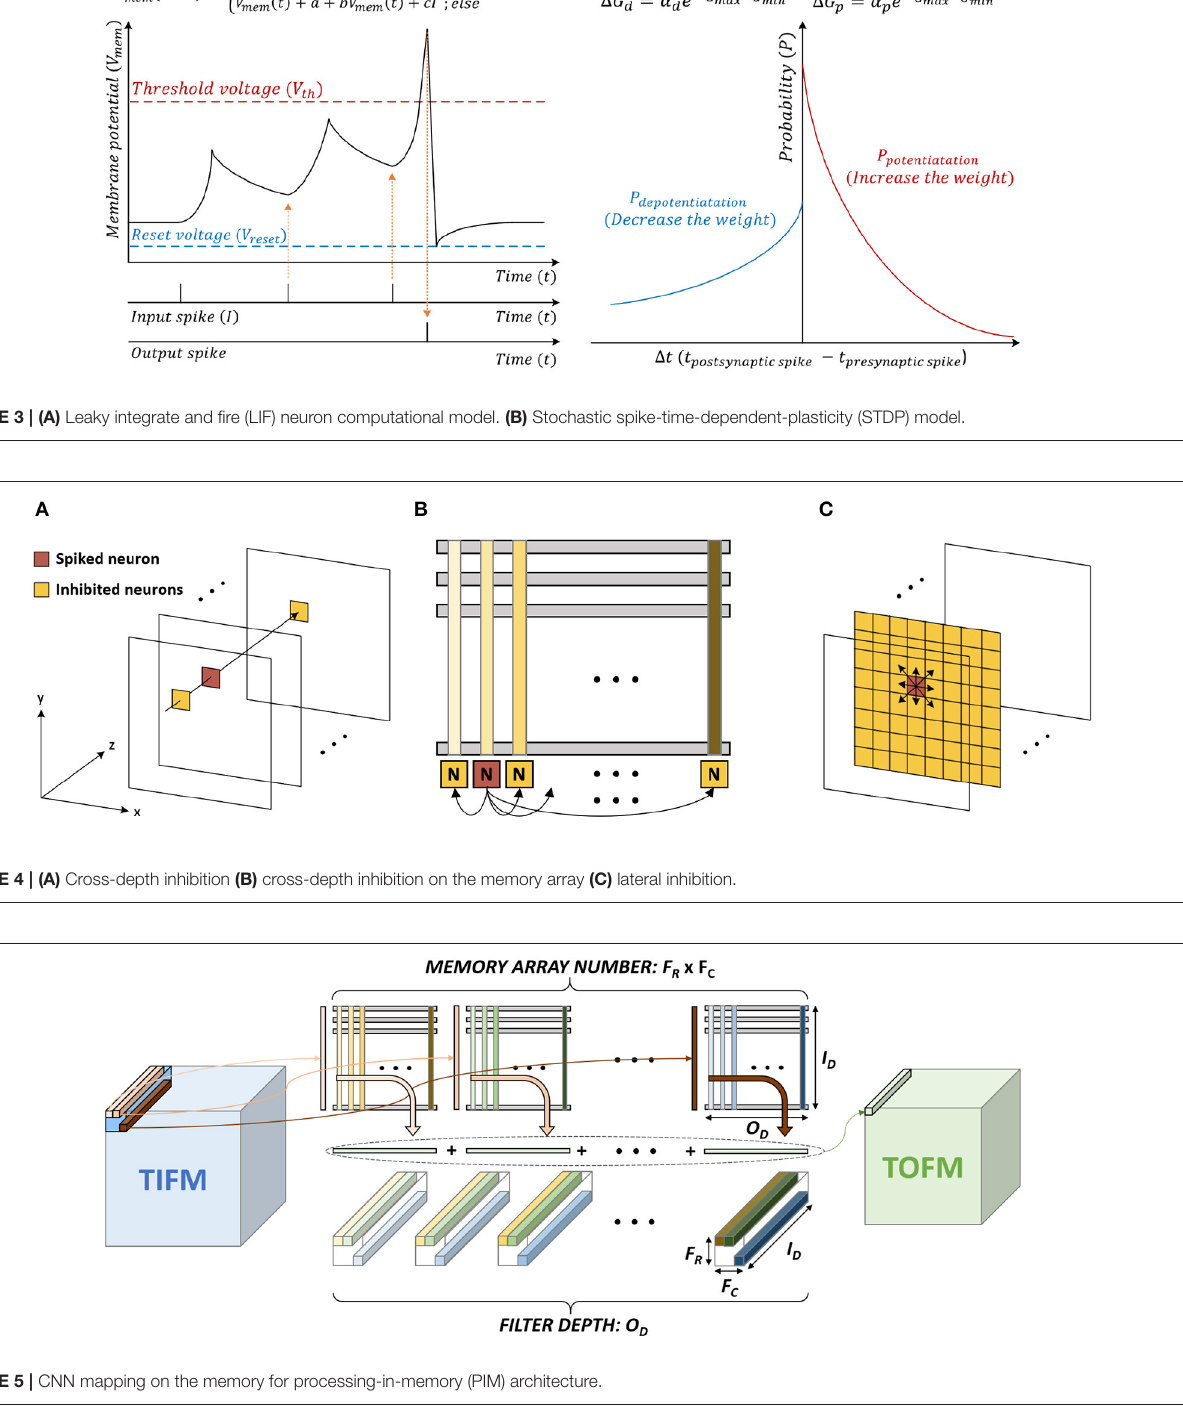
on the memory for the PIM architecture (Peng et al., 2021). Filter weights are divided by the x and y-axis, whose size is 1 × 1 × I D and distributed on the different memory arrays. Also, each